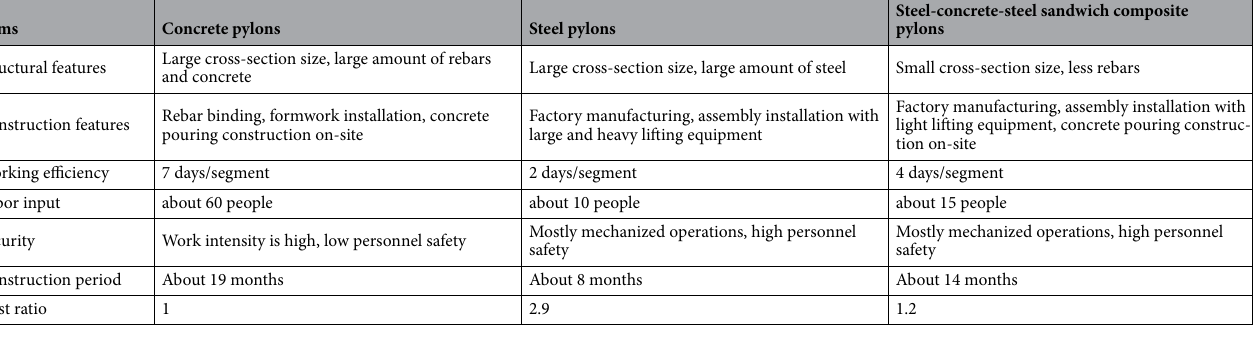
Table 5. Comparison table of concrete pylons, steel pylons and steel-concrete-steel sandwich composite